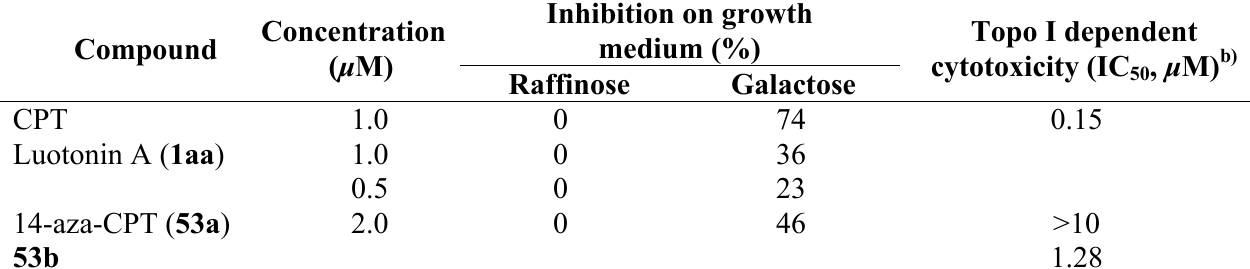
Table 4. Human Topo I dependent cytotoxicity of CPTs and luotonin A towards Saccharomyces cerevisiae .